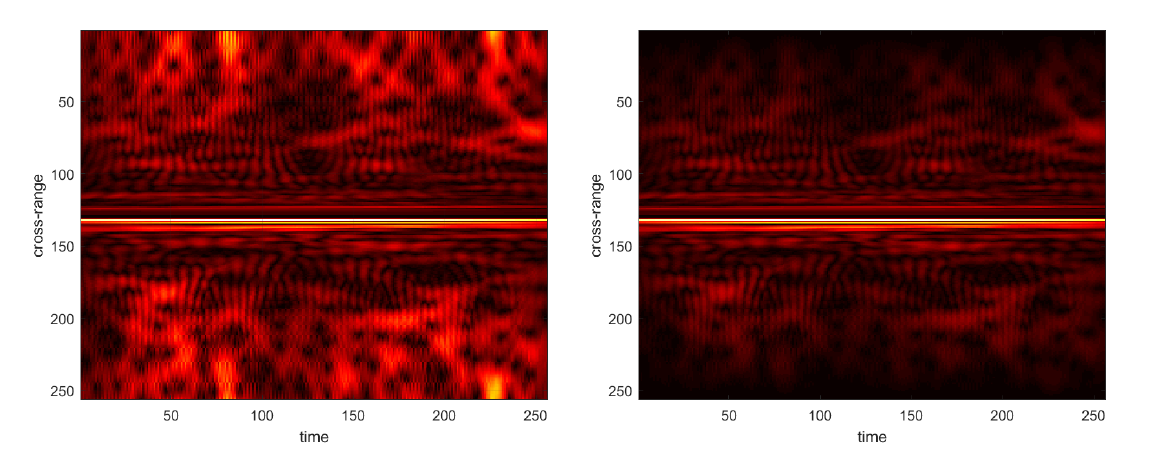
Figure 4. Preprocessed ST